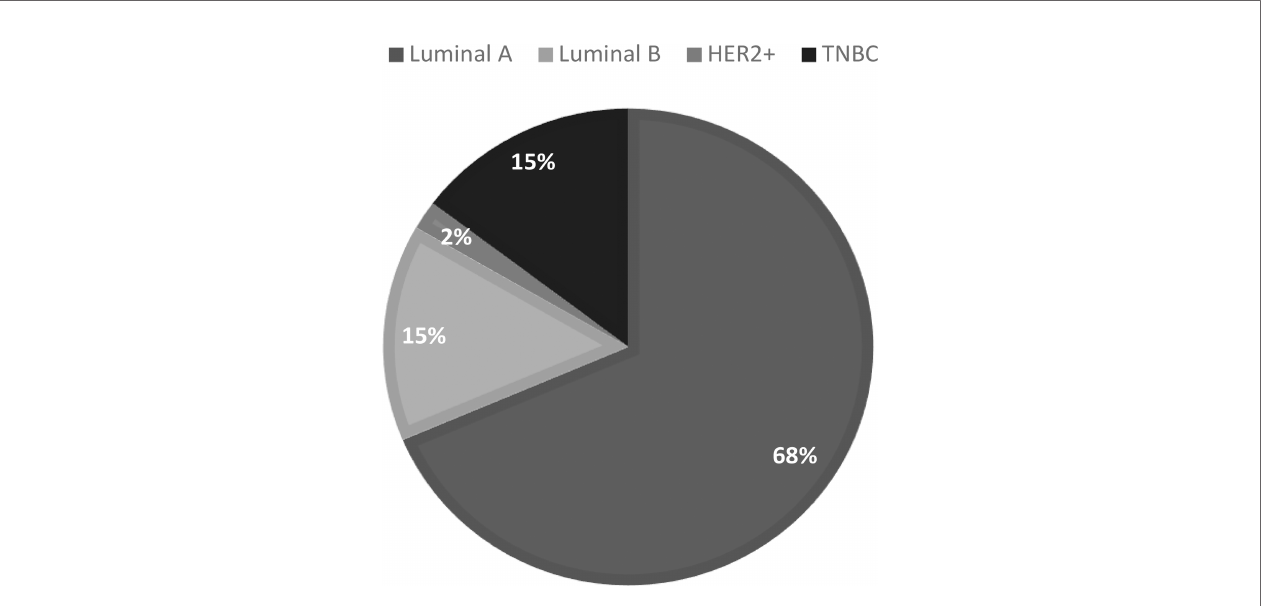
GRAPH 7 | Percentage of Female Breast Cases by Cancer